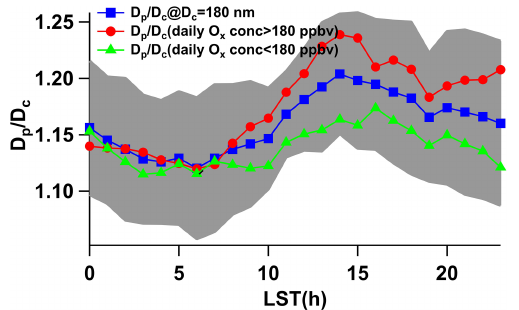
Figure 8. Diurnal variation in D p /D c for all periods, high-O x peri- ods and low-O x periods. The gray shaded area denotes the standard deviation of D p /D c for all